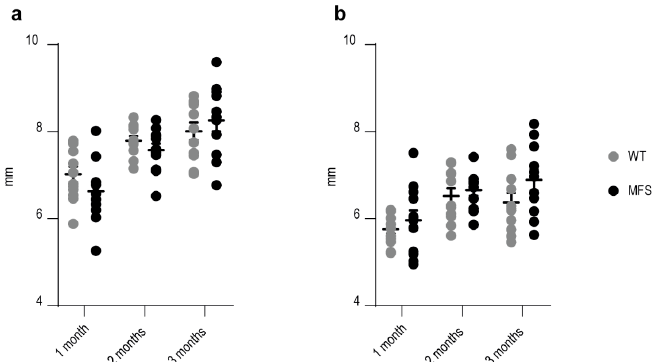
Figure A1. Macroscopic analysis of the cardiac dimensions of the dissected hearts of WT and MFS mice at the age of 1, 2, and 3 months ( n = 12/group). No significant difference in cardiac dimensions (length and width) was observed between WT and MFS mice (independent samples test; p ≥ 0.132) ( a ): dot plot visualizes the individual lengths of the dissected hearts and mean value per age group and genotype. ( b ): dot plot visualizes individual width of the dissected hearts and mean value per age group and genotype. WT and MFS measurements are indicated in grey and black, respectively. Error bars represent standard error. WT, wild-type; MFS, Marfan syndrome.